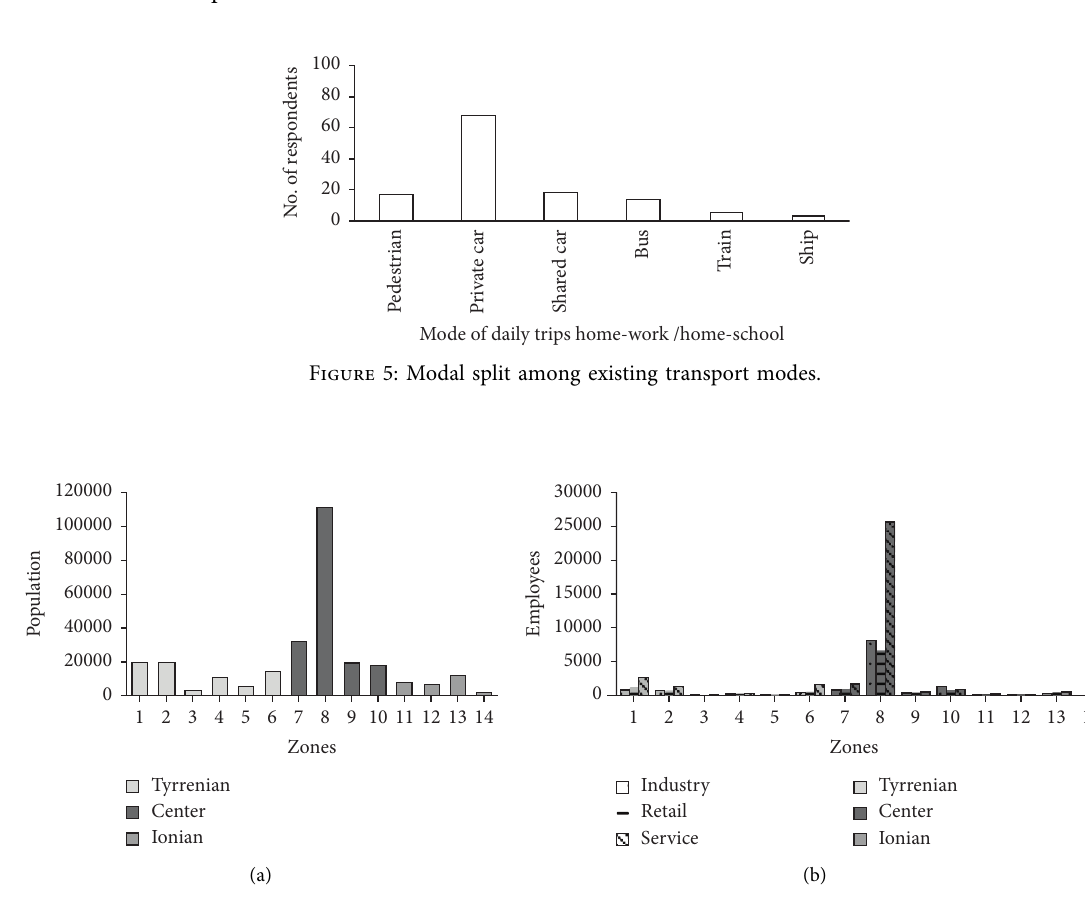
Figure 6: Distribution of (a) population and (b) industry, retail, and service employees.